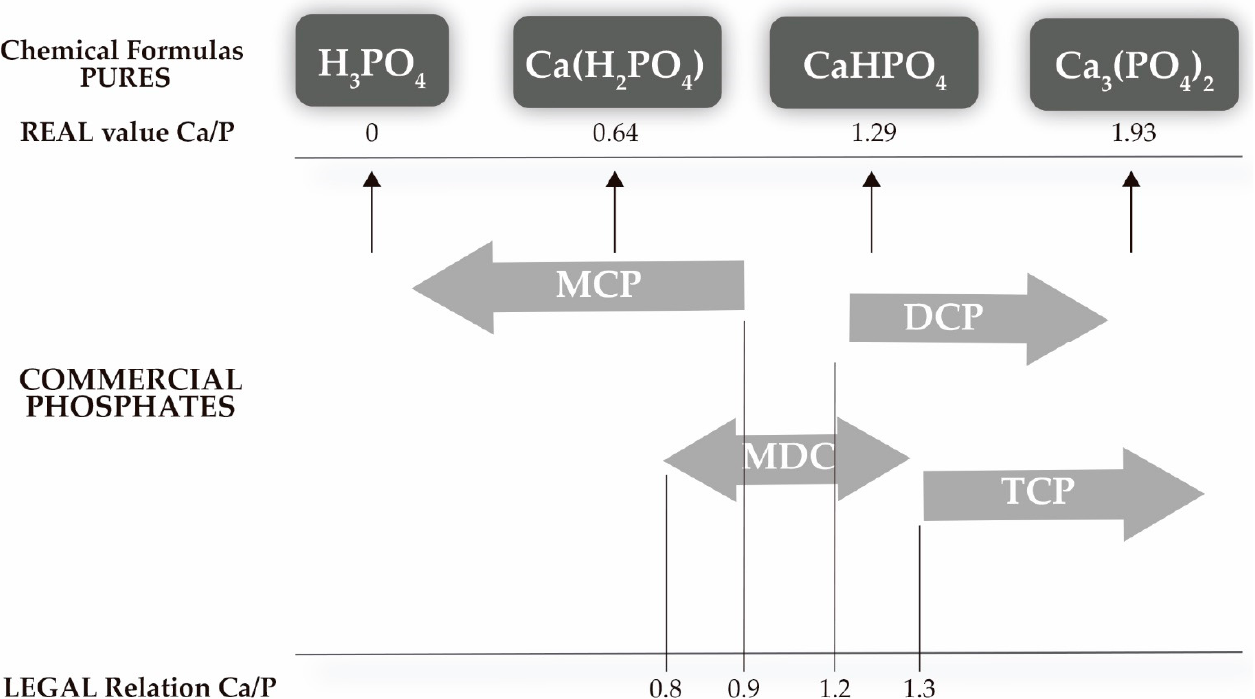
Figure 1. Characterization of commercial phosphates following the European Union Regulation [18] following the proportion of monocalcium phosphate (MCP), dicalcium and tricalcium phosphate (DCP and TCP, respectively) and phosphoric acid [20].